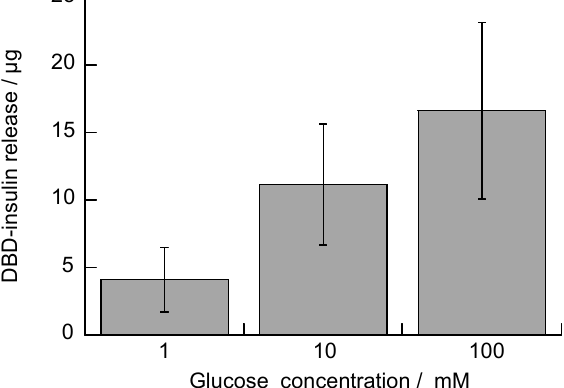
Figure 11. Absorbance at 255 nm resulting from the H 2 O 2 -induced decomposition of (SA-PAH/PBA-PAH) 5 films on CaCO 3 microparticles in a 10 mM CHES buffer (pH 9.0) containing 1 M NaCl in the presence of 0, 0.1, 1 or 10 mM H 2 O 2 .